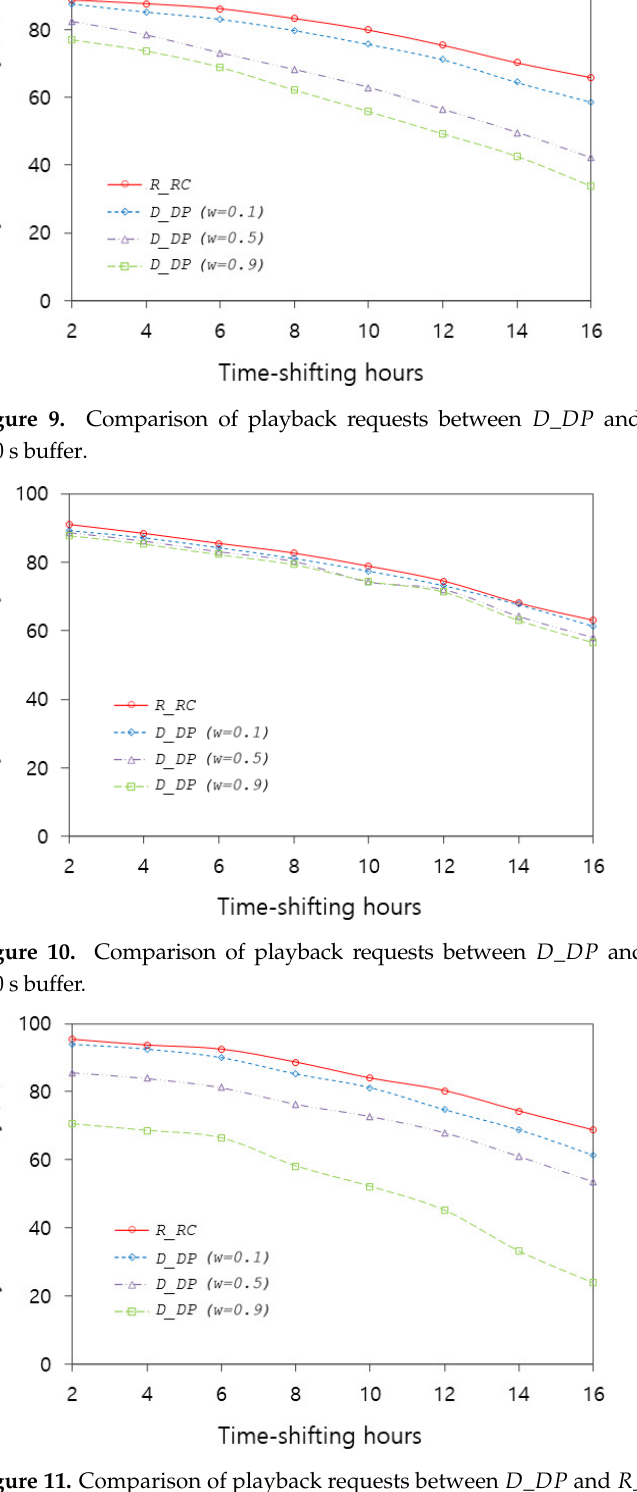
Figure 11. Comparison of playback requests between D _ DP and R _ RP in distribution 1 with a 150 s buffer when the number of PVRs is